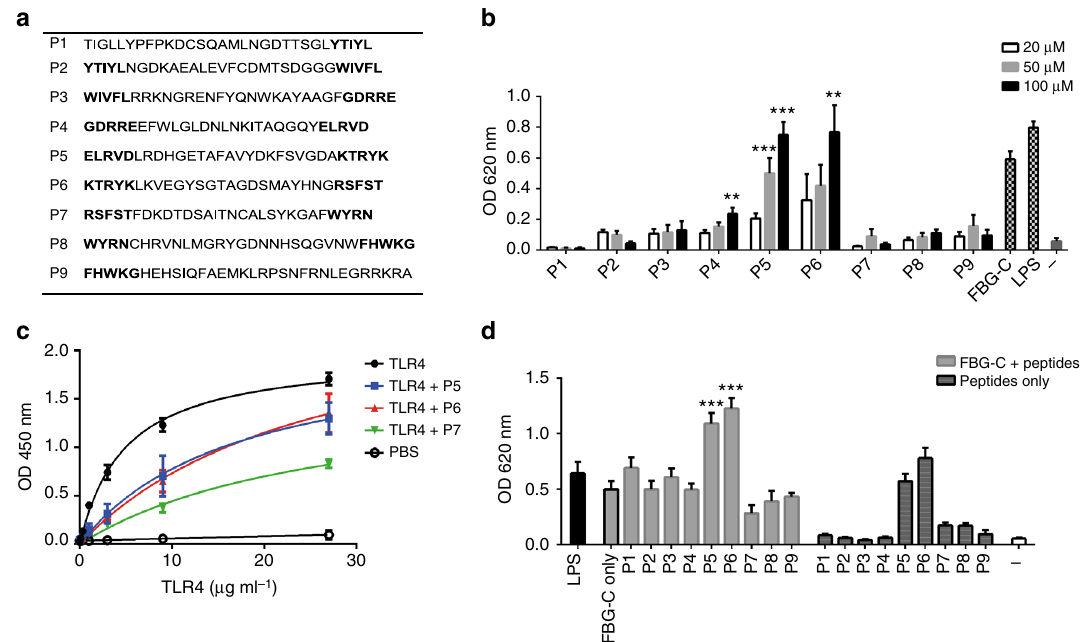
Fig. 2 Peptide mapping reveals speci fi c regions in FBG-C involved in TLR4 activation and binding. a Nine peptides of ~30 amino acids long from FBG-C were synthesized; overlapping amino acid sequences are shown in bold. b THP1 NF-kB cells were stimulated with LPS (0.5 ng ml − 1 ), FBG-C (0.5 µ M), or 20, 50, or 100 µ M of peptides 1 – 9 for 24 h and NF-kB activation was measured using QUANTI-Blue ™ . Data shown as mean ± SEM, n = 4 independent experiments. One-way ANOVA vs. unstimulated cells. ** p < 0.01, *** p < 0.001. c Increasing doses of TLR4 were pre-incubated with 200 µ M of peptides before adding them to 96-well plates coated with 1 µ g ml − 1 of FBG-C. Curves were fi tted in GraphPad Prism using one-binding site hyperbola equation. Data are shown as mean ± SEM, n = 3. d THP1 NF-kB cells were left unstimulated ( − ) or pre-incubated with 100 µ M peptides prior to stimulation with 0.5 µ M of FBG-C for 24 h. NF-kB activation was measured using QUANTI-Blue ™ . Data shown as mean ± SEM, n = 3 independent experiments. Paired t -test vs. FBG- C only, * p < 0.05, ** p < 0.01, *** p <